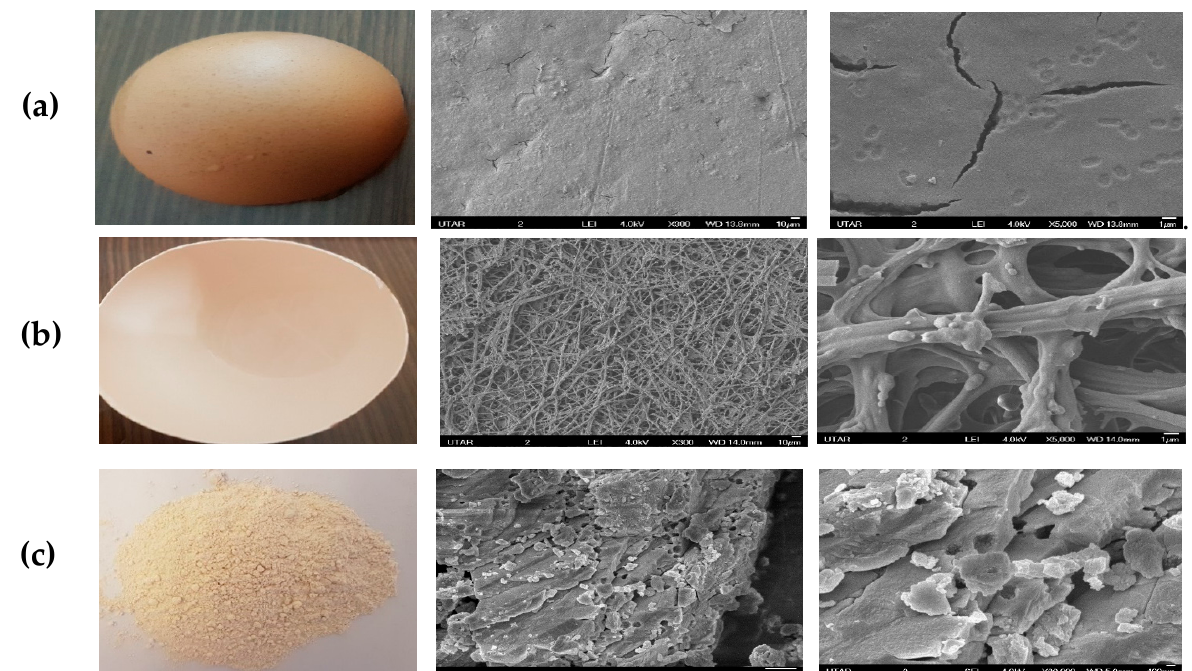
Figure 1. Digital camera and FESEM images of raw eggshell. ( a ) Outer at 300× and 5000× magnification, ( b ) inner at 300× and 5000× magnification, and ( c ) particle size of <90 µm at 10,000× and 30,000× magnification. Figure 2a,b show FESEM images of (CES 900 °C) and (CES 1100 °C). The images for 900 °C show a stable and structured particle compared to the one calcined at 1100 °C. (CES 900 °C) shows well-arranged particles with smooth surfaces on each particle. (CES 1100 °C) was totally the opposite, particles lose their shapes, and each particle shows intensive surface cracks due to the sintering process.